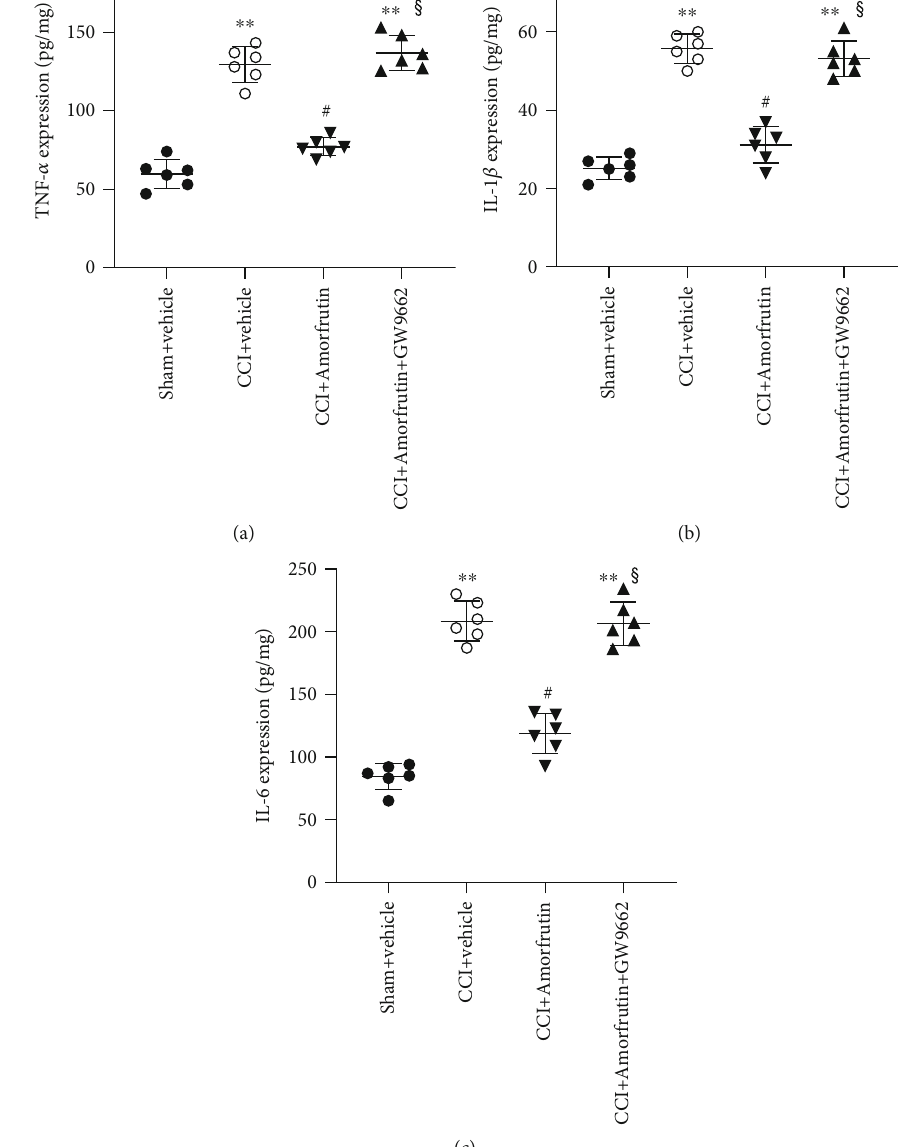
Figure 3: Amorfrutins reduced the in fl ammation in CCI rats. (a) The TNF- α expression in the spinal cord of di ff erent groups were detected using ELISA. (b) The IL-1 β expression in spinal cord of di ff erent groups were detected using ELISA. (c) The IL-6 expression in spinal cord of di ff erent groups was detected using ELISA. Amorfrutins reduced the levels of TNF- α , IL-1 β , and IL-6 through PPAR γ